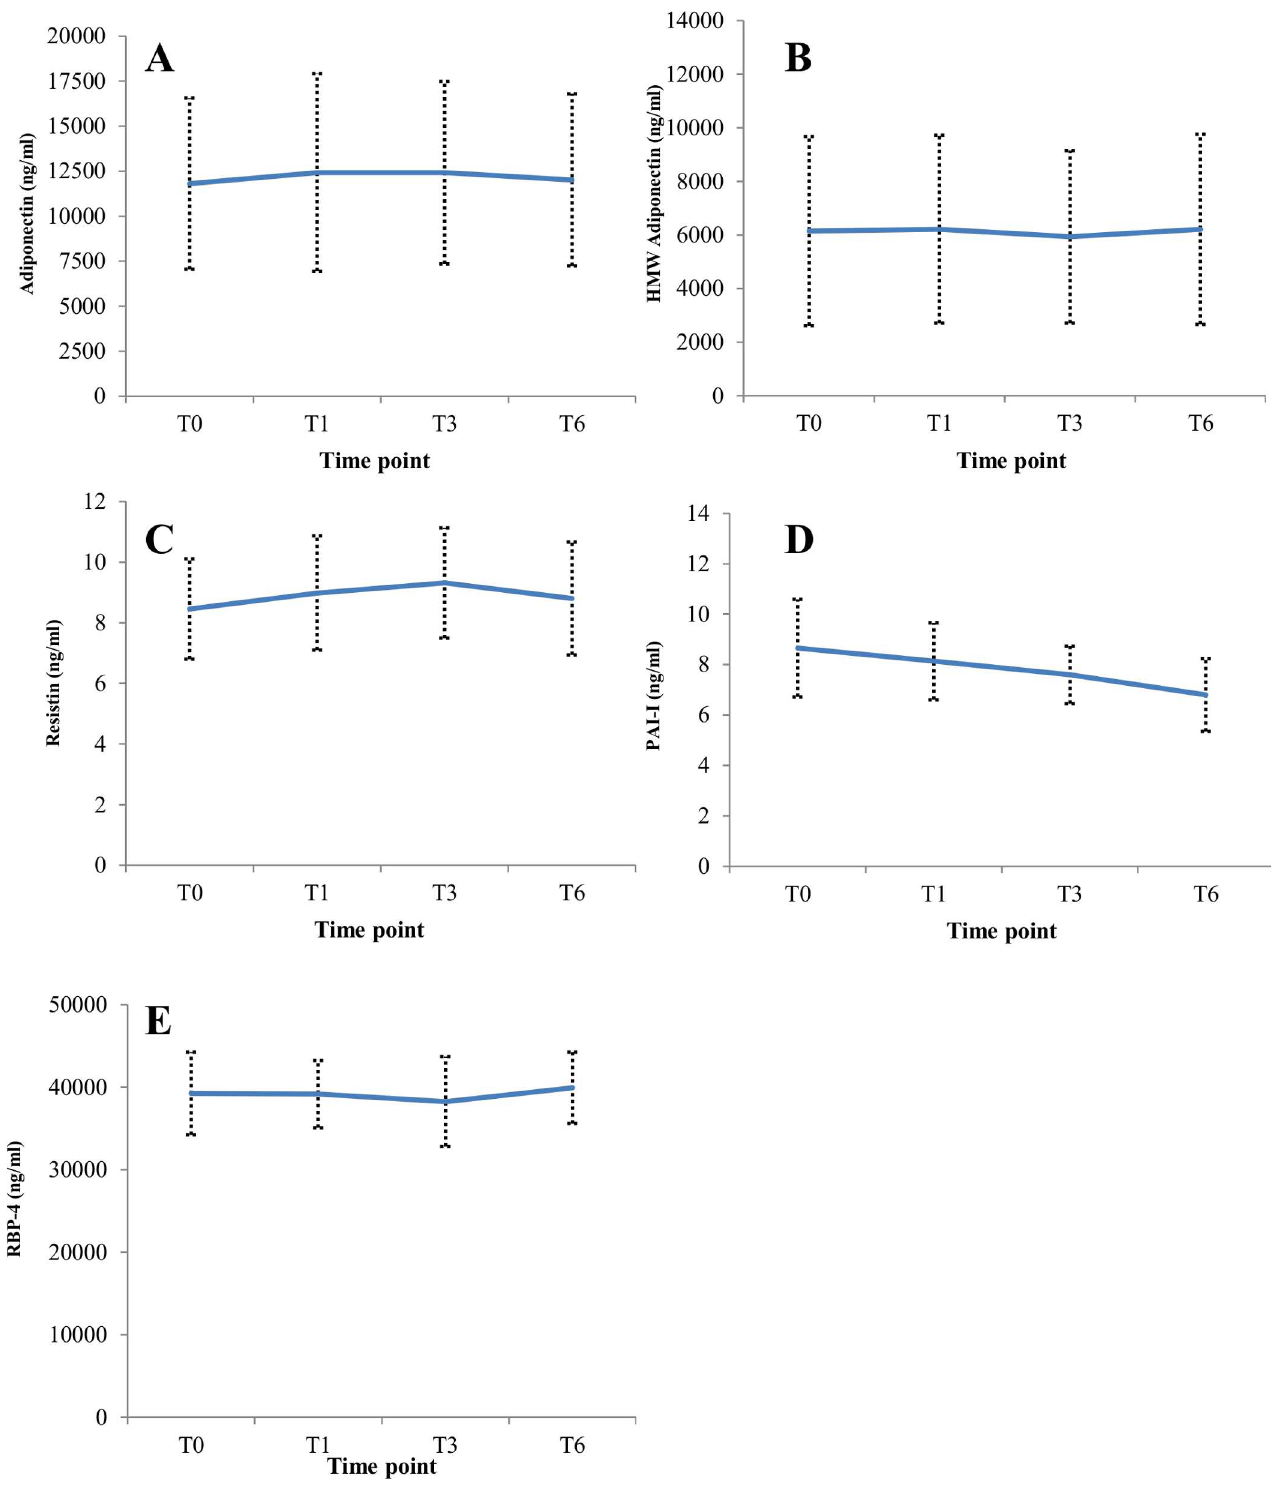
Fig 2. Medians and median absolute deviation (MAD) of serum (A) adiponectin, (B) HMW adiponectin, (C) resistin, (D) PAI-I, and (E) RBP-4 after an overnight fast (T0), and 1 hour (T1), 3 hours (T3), and 6 hours (T6) after the researchbreakfast.